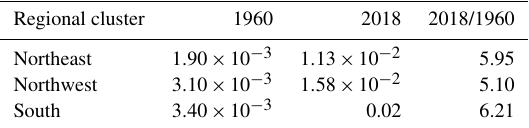
Table 3. Regional tail probability estimates (in units of occurrences per year) for weekly temperature extremes above 35 ◦